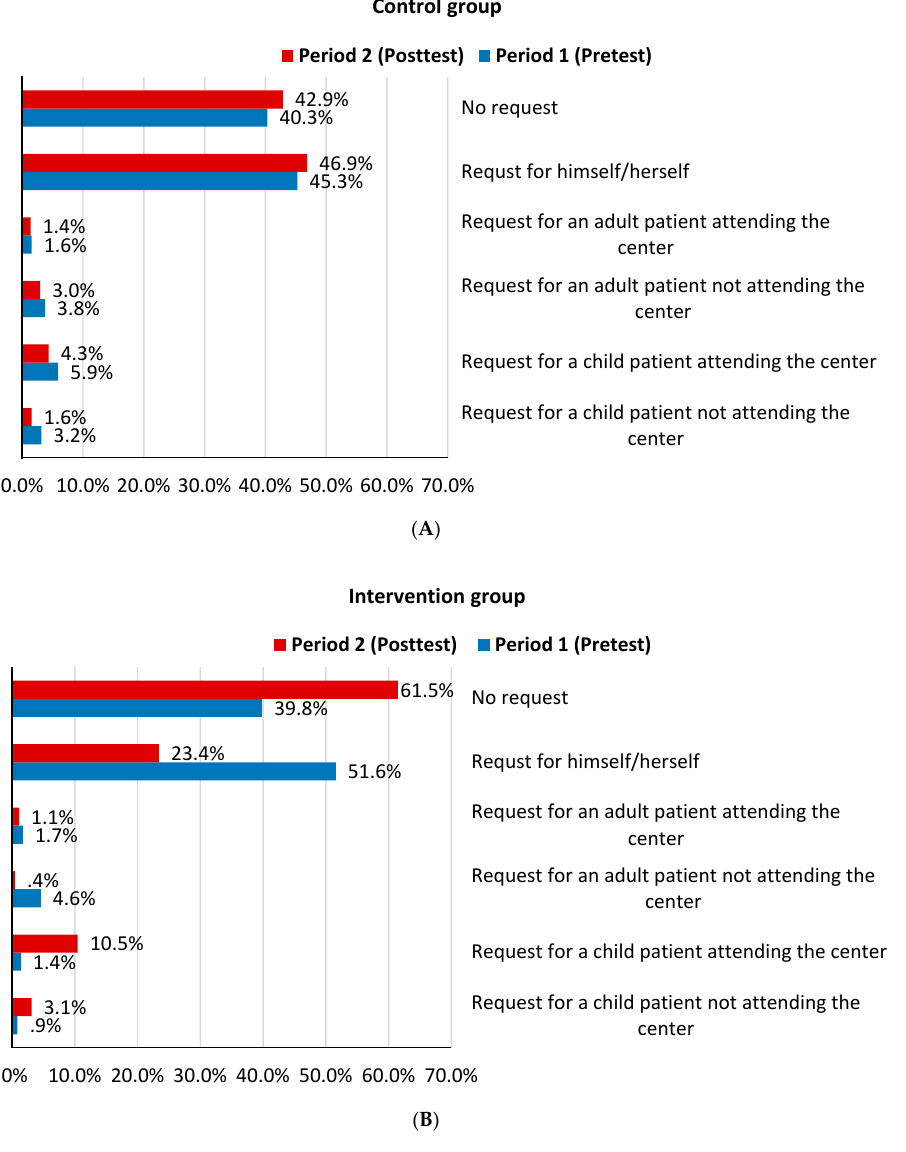
Figure 2. The pattern of antibiotics requests in the control or intervention groups. A horizontal bar graph displaying the pattern of antibiotics request in period 1 ( blue ) and period 2 ( red ) in ( A ) Control or ( B ) Intervention groups. Each bar represents the percentage of individuals that either did not